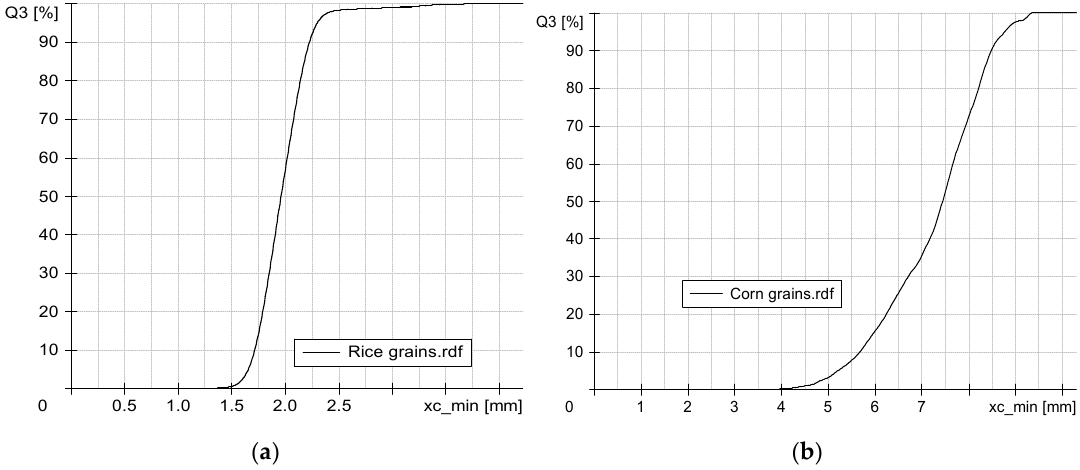
Figure 1. Granulometric distribution of ( a ) rice grains ( b ) corn grains.